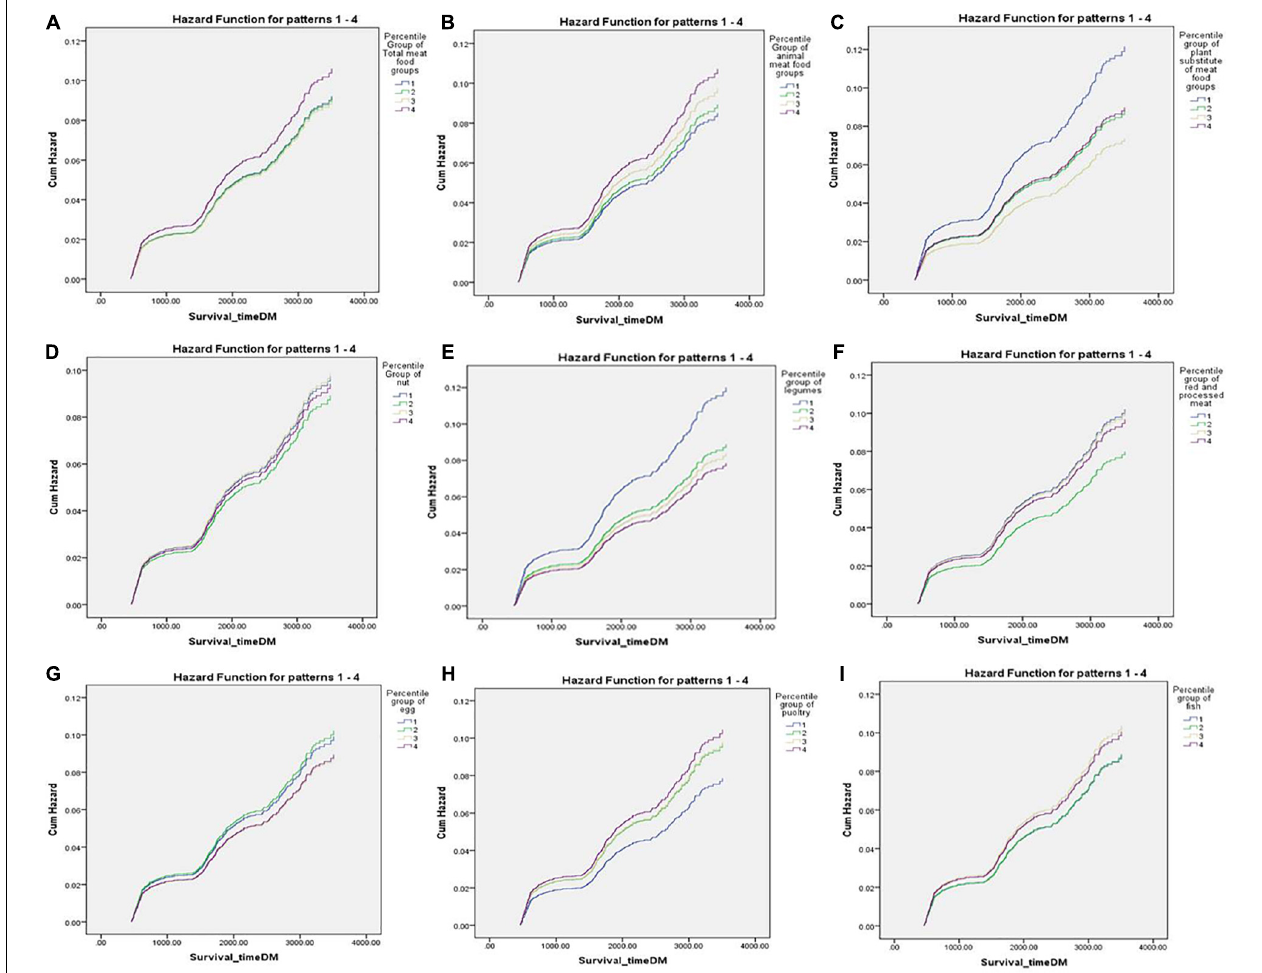
FIGURE 2 | Cox proportional hazard regression plot for type 2 diabetes according to quartiles of total meats, animal sources of meat food groups, plant sources of meat food groups, nuts, legumes, red and processed meats, egg, poultry, and fish (A–I)